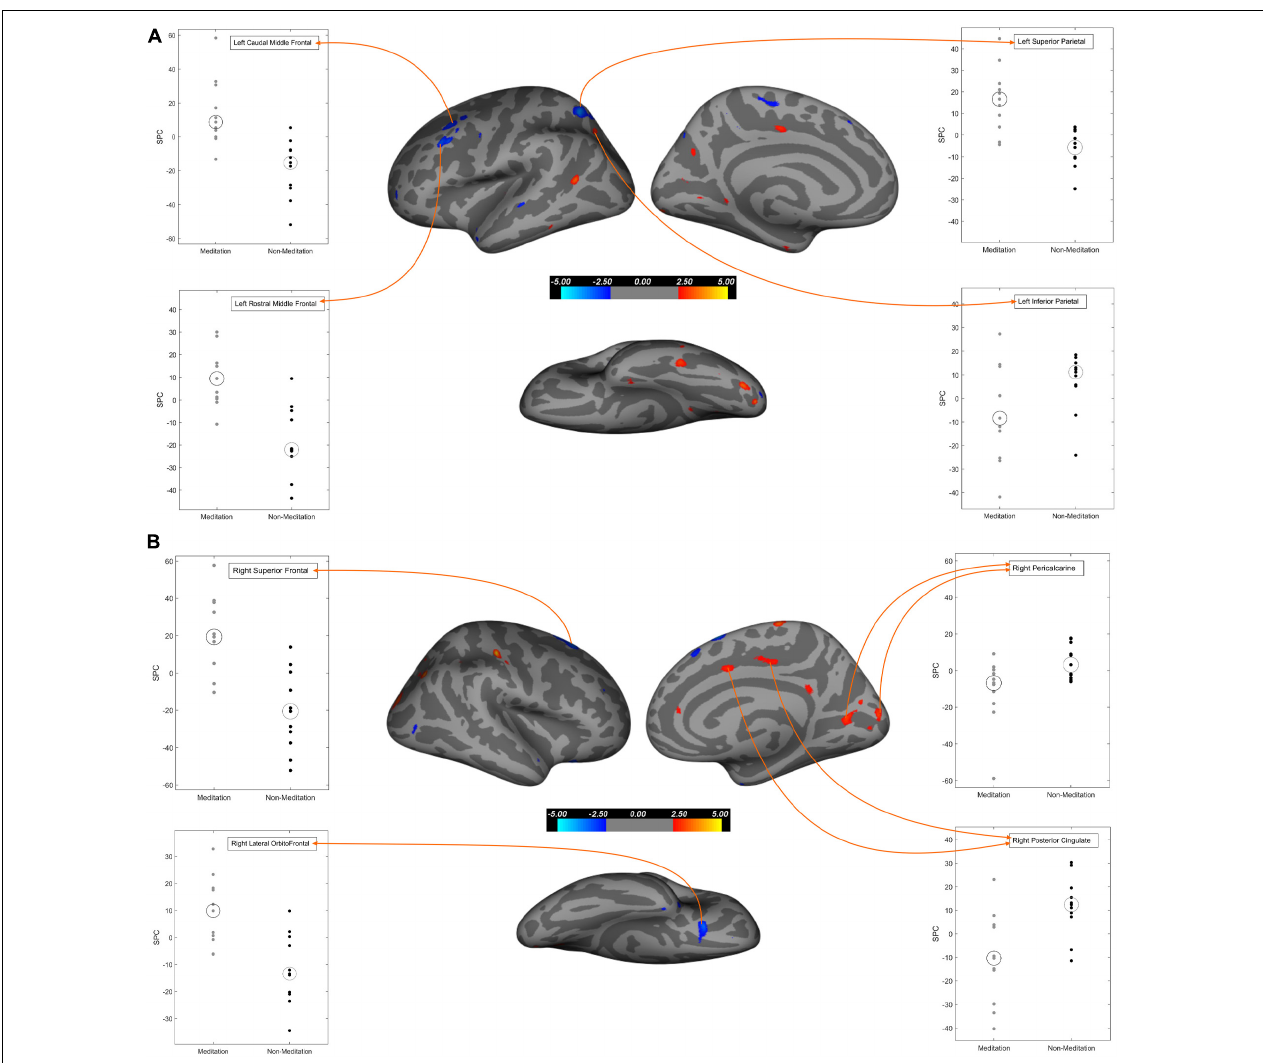
FIGURE 1 | Regions of cortical thickness that exhibit significant differences between meditation and non-meditation cohorts corrected for multiple comparisons, age, gender, and education. In all three different views (Lateral, medial, inferior) of brain surfaces, the blue clusters represent significantly higher SPC values while the red clusters represent significantly lesser SPC values in the meditation group compared to the non-meditation group. Graphs for significantly large cluster sizes are annotated on the inflated brain surface (see Table 5 for more details). (A) Left hemisphere; (B) Right